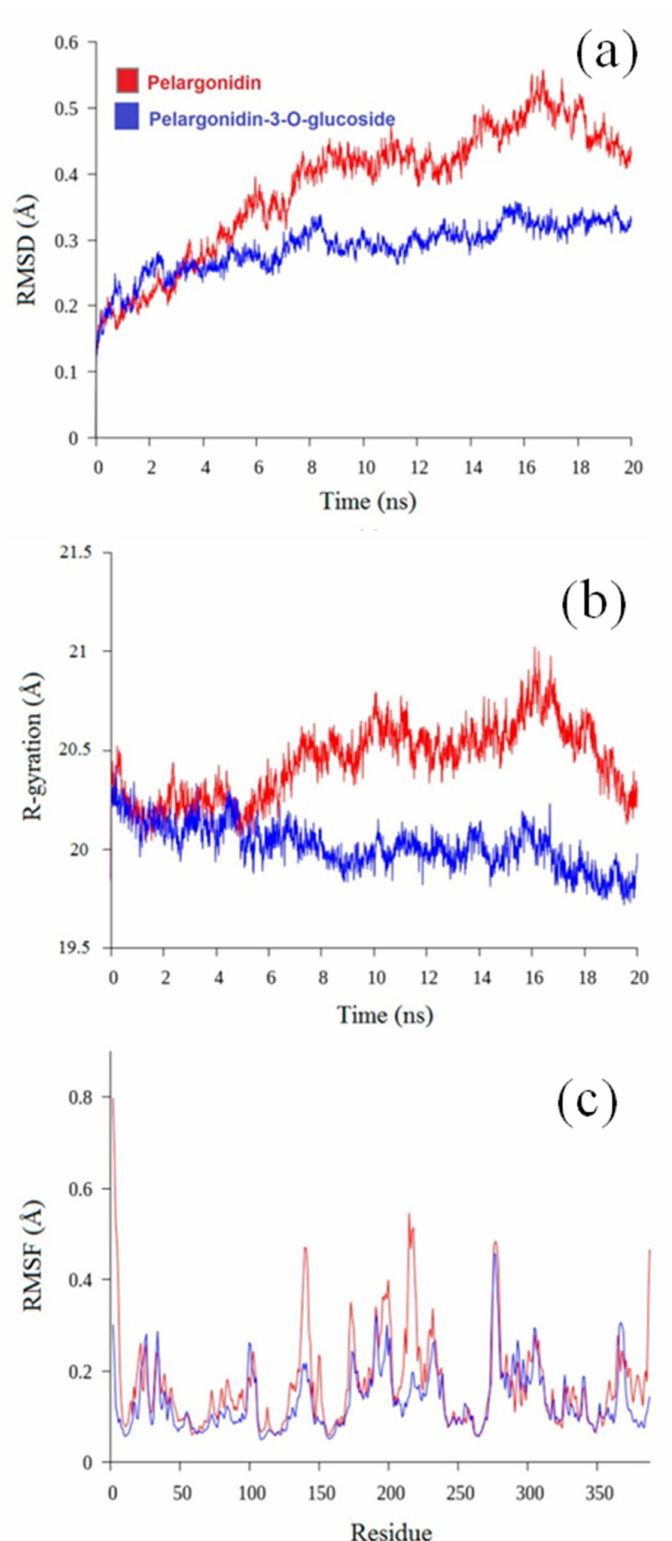
Figure 6. RMSD ( a ), radius of gyration ( b ) and RMSF ( c ) for pelargonidin and pelargonidin-3-O- glucoside with